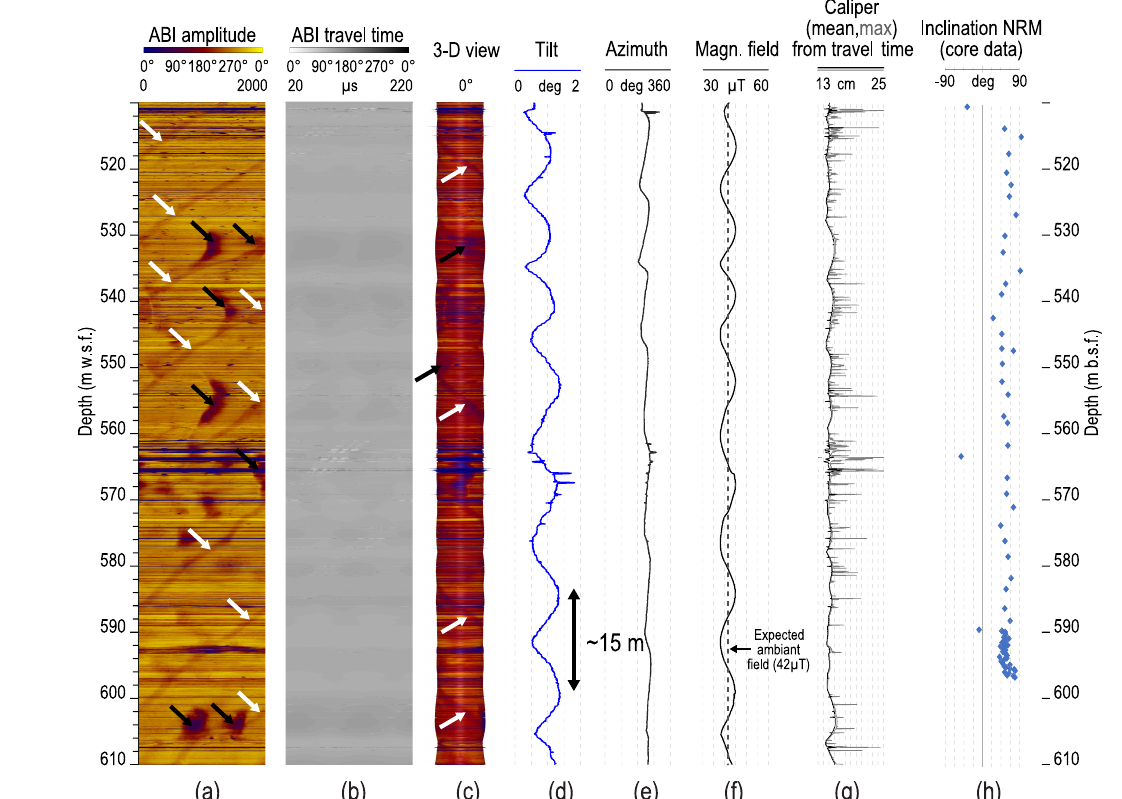
Figure 6. Drilling-induced corkscrew borehole shape in the post-impact carbonates, possibly due to drill bit wobble, steel wedged at the bit or overfeed of rods. This shape (see also Fig. 2c) is evidenced by cyclic oscillations in both accelerometer (tilt) and magnetometer (azimuth) data (d, e) . One continuous regular spiraling narrow dark stripe (white arrows in a and c ) may result of the drill pipe rubbing on the carbonate formation. Drilling induced re-magnetization of the formation is tentatively proposed to account for the cyclic changes observed in the magnetic field (f) . (h) Non-demagnetized NRM measured on core samples dominated by positive inclination (indicative of normal polarity), suggesting a pervasive normal polarity remagnetization. mw.s.f. is meter wireline depth below seafloor; mb.s.f. is meters below